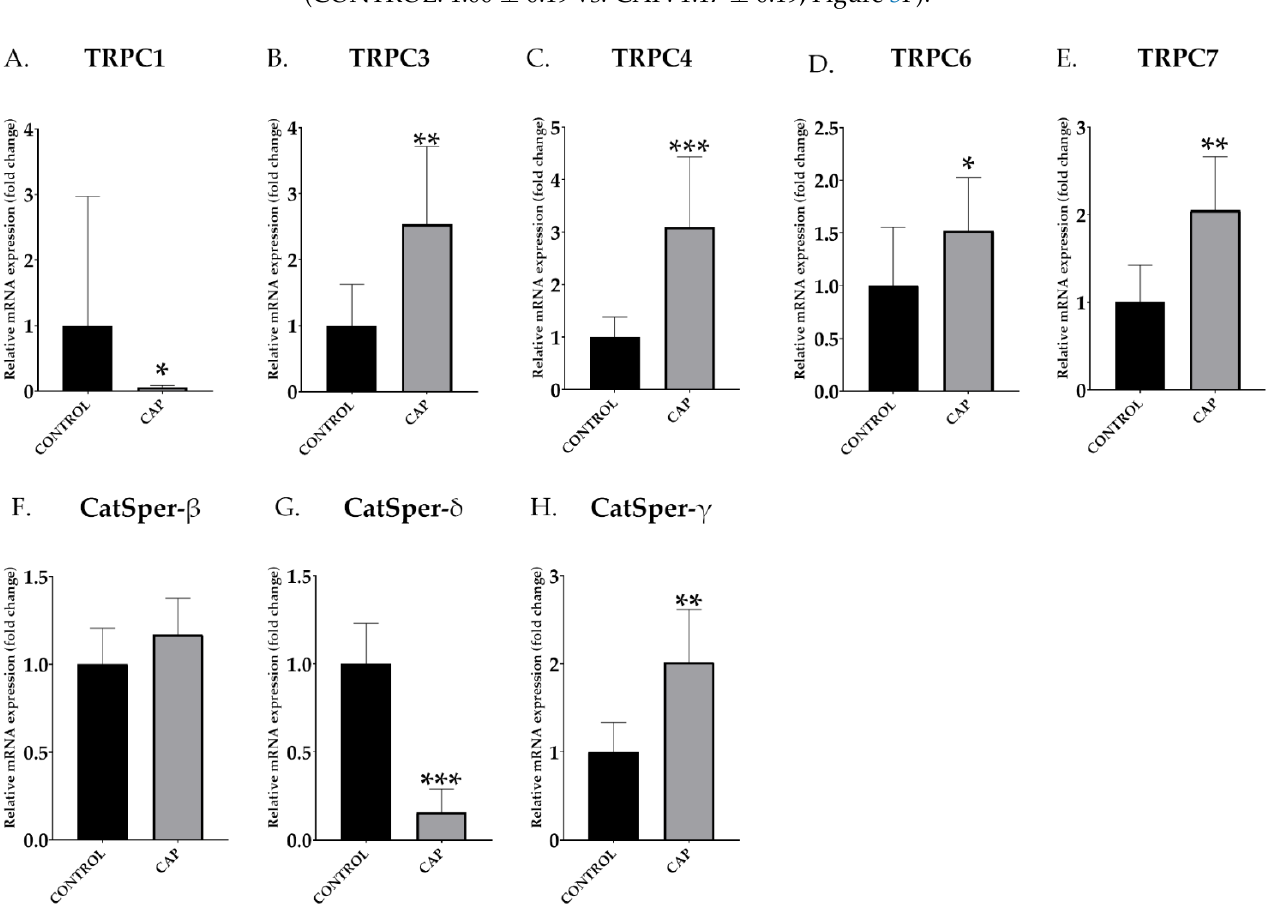
Figure 3. Relative abundance of mRNA transcripts of different TRPC and CatSper subunits control (CONTROL) and in vitro capacitated (CAP) boar ejaculated spermatozoa ( n = 5). The values from mRNA expression have been represented relative to control, using a relative value of the control equal to 1. The results are shown as mean ± SEM. * Depicts significant differences between CONTROL and CAP (* p < 0.05, ** p < 0.01, *** p < 0.001).